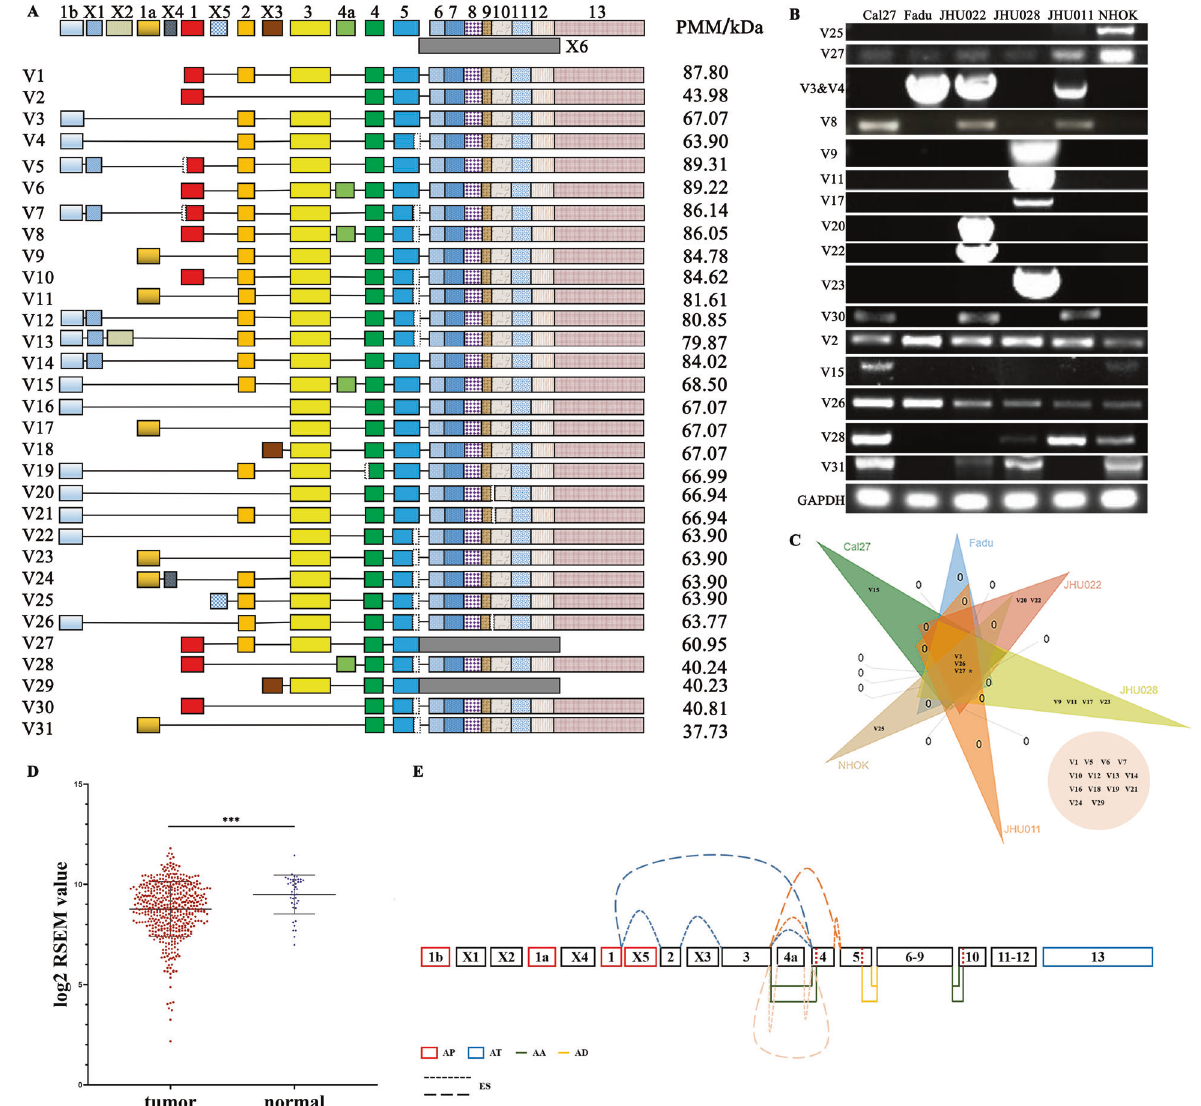
Fig. 1 Expression of TACC1 variants in HNSCC. A Diagrammatic representation of TACC1 variants. In GenBank, human TACC1 (Gene ID:6867) mRNA has a total of 31 encoding transcript variants. B Expression analysis of TACC1 variants in NHOK and HNSCC cell lines by RT-PCR. TACC1 v25 and 27 exhibit higher expression in NHOK cells. C Venn diagram of describing the differential expression patterns of TACC1 variants in HNSCC cell lines and NHOK cells. *TACC1v27 was expressed in all cell lines, but there was a signi fi cant difference in expression levels between HNSCC lines and NHOK cells. Round circle, negative variants in all cells. D Analysis of TACC1v25 expression in HNSCC samples by TCGA. In normal tissue samples, TACC1v25 showed higher expression than that in primary HNSCC tissue samples. E Analysis of AS events associated with TACC1 in HNSCC by TCGA. Box with colour, exon; blank box, lacking region of exon; arrow, location of primers. T, HNSCC samples; N, normal controls ( *** P < 0.001). Note: The nomination of TACC1 exons was in line with ref. [15]. Exons X1-X6 were named by our